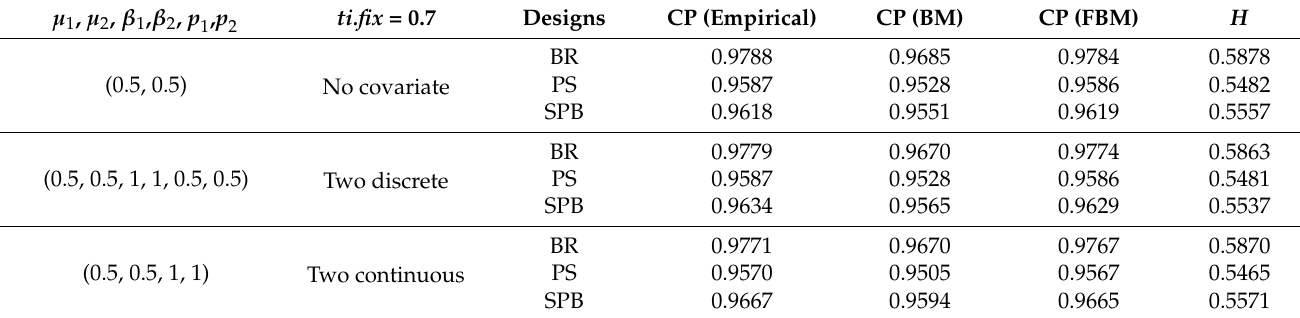
Table 5. CPs under misspecification scenarios: ε ’s ~increments of FBM, H = 0.9, drift = 2.